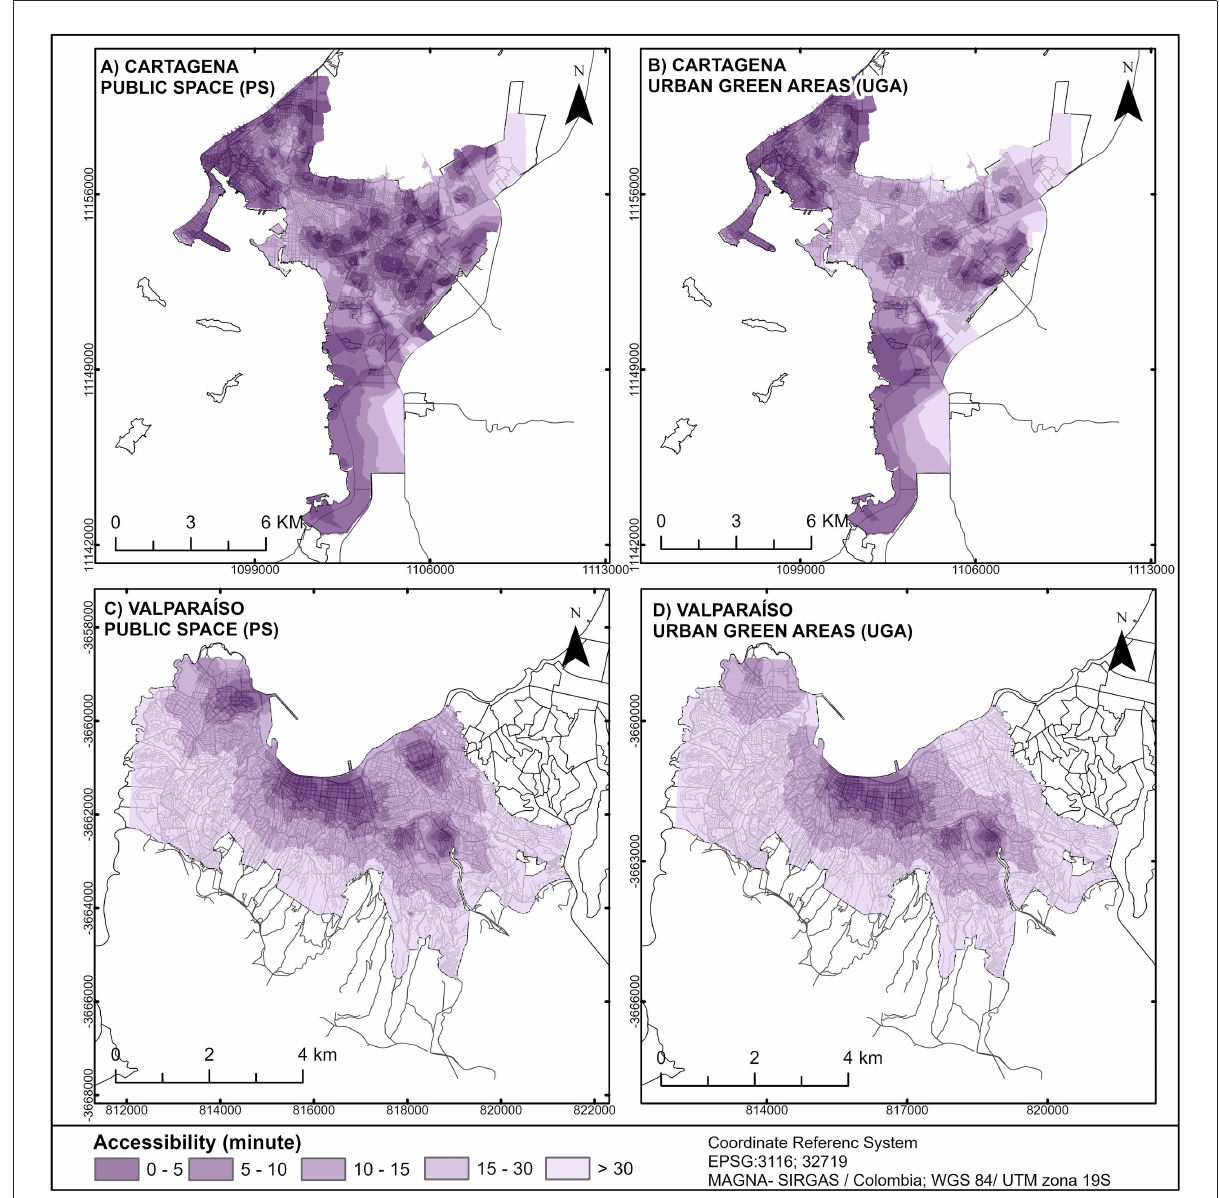
FIGURE7 Accessibility to public spaces (left) and to UGA (right) in walking distance [minutes]: Cartagena (A,B) and Valparaiso (C,D) , respectively. Source: Prepared by the authors.